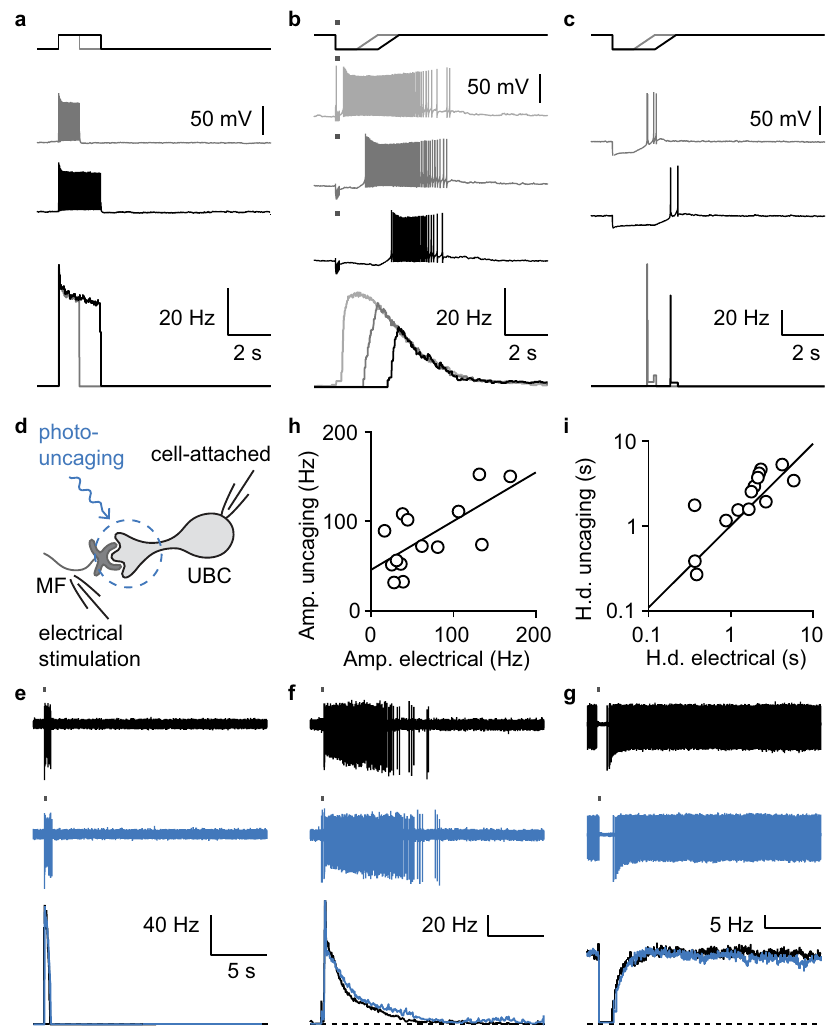
Fig. 4 Diversity in fi ring following mossy fi ber activation does not result from voltage-dependent active ampli fi cation but re fl ects intrinsic synaptic differences in UBCs. a Sample spiking responses in current clamp to 1 s (gray) or 2 s (black) current injections and their corresponding fi ring rates (bottom). b Sample spiking responses in current clamp to MF stimulation alone (light gray) or in conjunction with a 1 s (dark gray) or 2 s (black) hyperpolarizing step and their corresponding fi ring rates (bottom). c Sample spiking responses in current clamp to 1 s (light gray) and 2 s (dark gray) hyperpolarizing steps and their corresponding fi ring rates (bottom). d Schematics of the electrical stimulation and optical glutamate uncaging experiment. e Example spiking response to electrical (black, top) or optical stimulation (blue, middle) and their instantaneous fi ring rate (bottom) for a fast UBC. f Same as in b but for a slow UBC. g Same as in b but for a UBC that was suppressed by MF stimulation. h Correlation between the amplitudes of the glutamate- uncaging and electrical spiking responses, linear fi t ( R adj 2 = 0.33, slope = 0.42, intercept = 52, n = 14). i Correlation between the half-decay times of glutamate-uncaging and electrical spiking responses, linear fi t on log 10 transformed data (black, R adj 2 = 0.51, slope = 0.92, n =